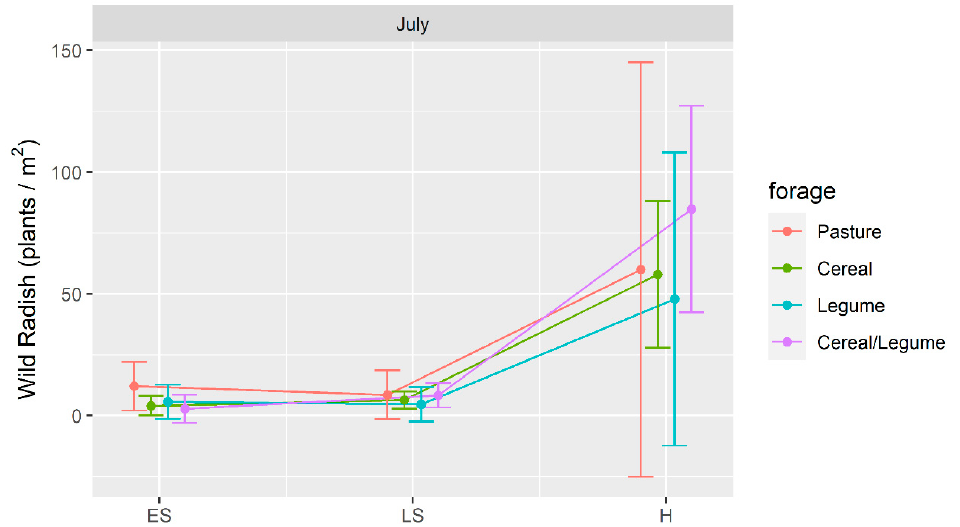
Figure 5. Wild radish plant density (plants/m 2 ) present in a wheat crop following winter forage crops grown at Wagga Wagga, NSW in 2015 compared to an unsown pasture. Forage crops were harvested as early silage (ES), late silage (LS) or hay (H). Data displayed as the mean ( • ) ± 2 × standard error (length of line in each direction).